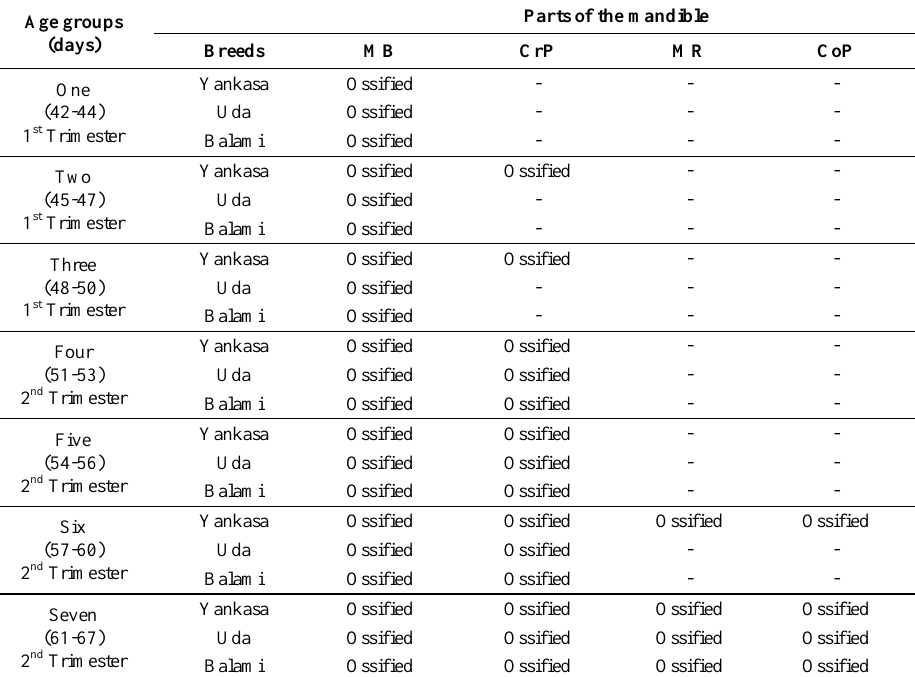
Table 1. Time and sequence of ossification of the Mandible in the three breeds of